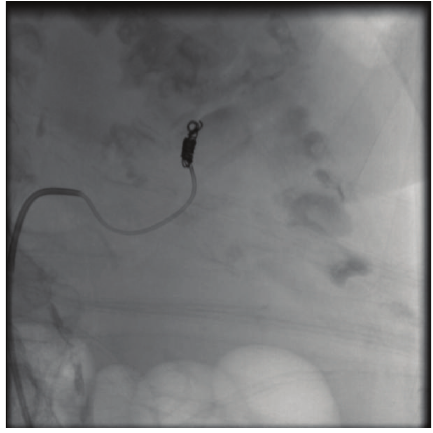
Figure 6: Left renal angiography and embolisation. Coil seen. Note also the accessory renal artery occluded with occlusive glue (Glubran), not